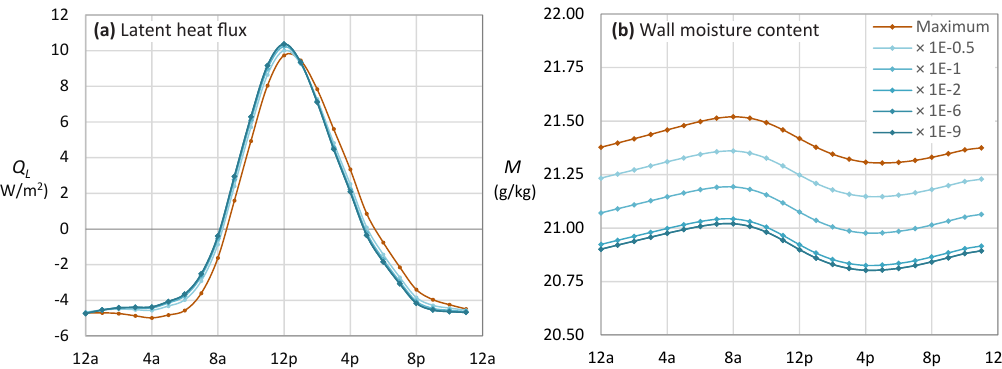
Figure 16. Effect of varying the liquid transport coefficient D (Figure 15) on ( a ) latent heat flux Q L and ( b ) wall moisture content M in rammed earth walls, illustrating the relative unimportance of D to both Q L and M under the conditions investigated, and its resulting apparent insignificance for intrinsic evaporative cooling. Data show average hourly July values in the marine west-coast climate of Birmingham, UK (Köppen Cfb , Figure 9, Table 3) for south-facing walls of well-characterized rammed earth [51–53]. Ambient humidity was the only source of